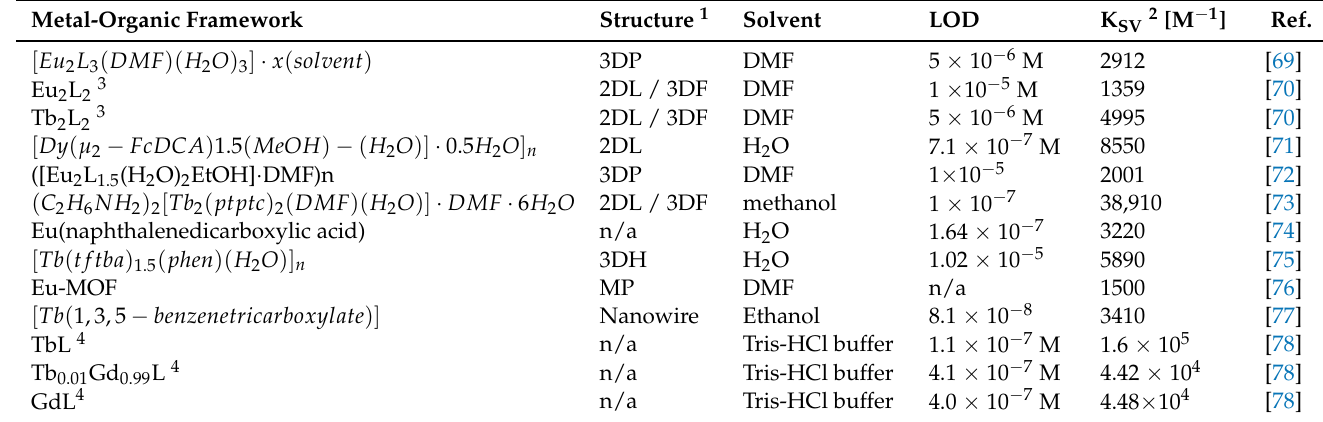
Table 3. Summary of lanthanide-based metal–organic frameworks used to detect picric acid. Metal-Organic Framework